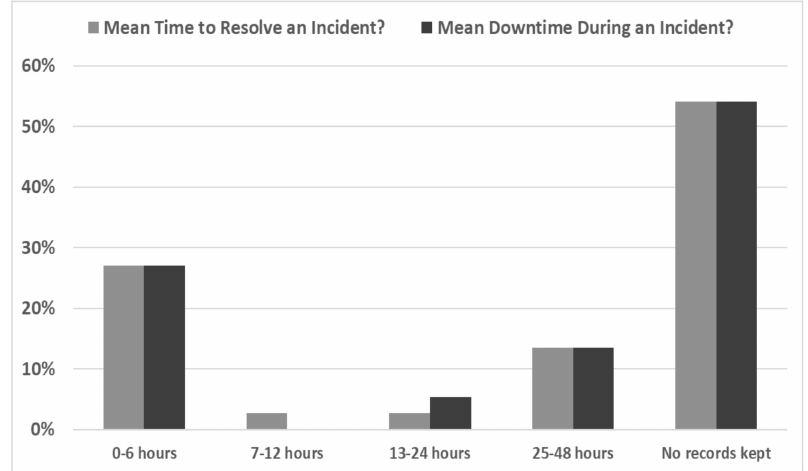
Figure 4. Cybersecurity Incident: Downtime and Time to